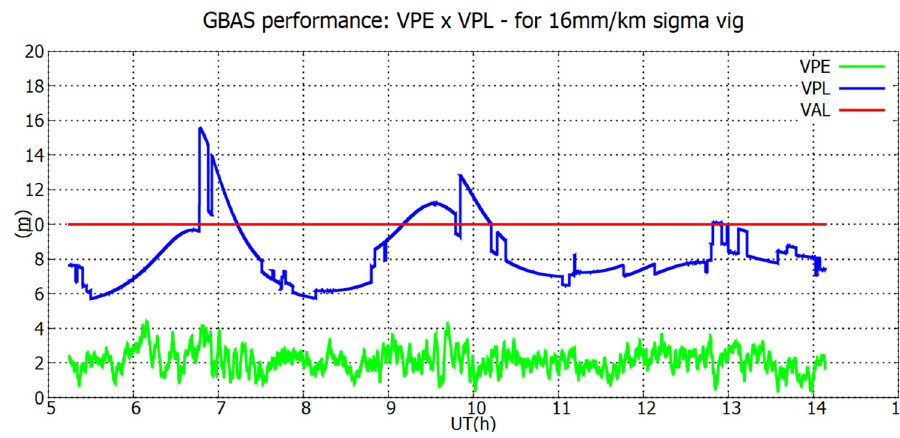
Figure 13: Performance of positioning errors and protection levels for GBAS simulation considering σ vig of 16